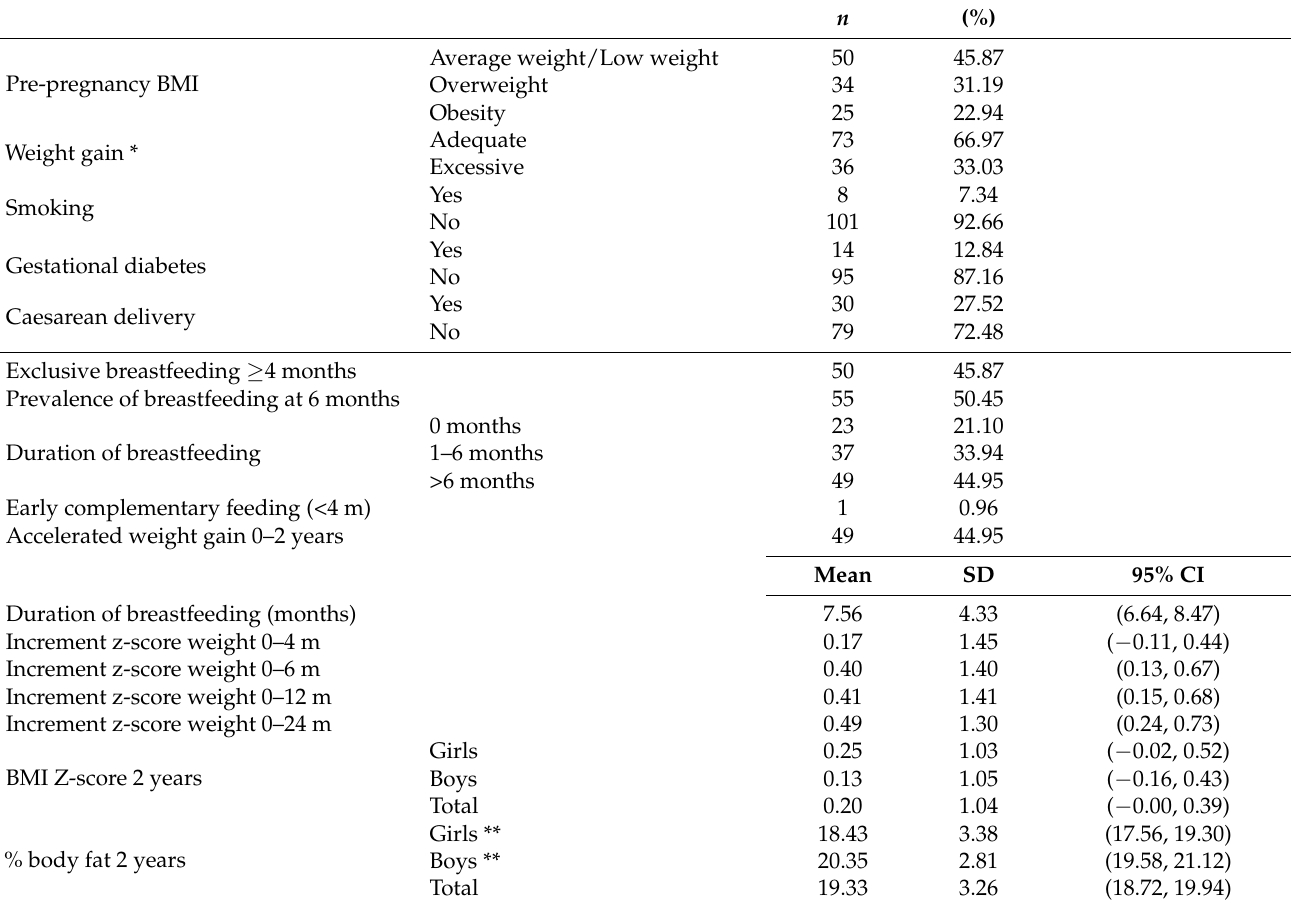
Table 2. Variables associated with early risk factors ( n =